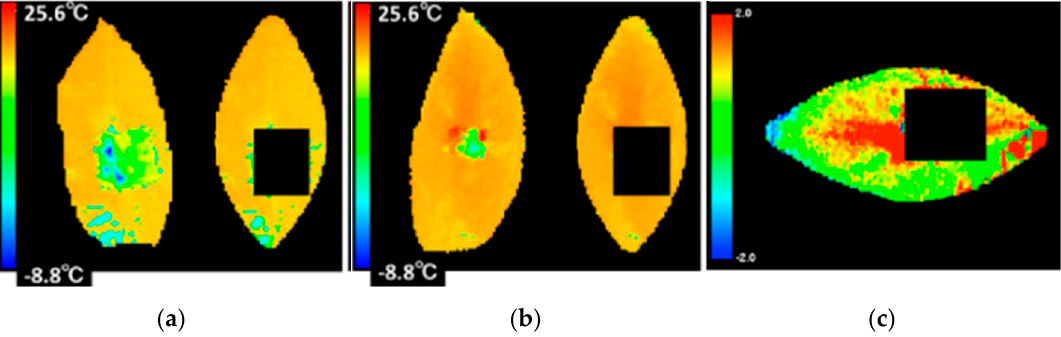
Figure 18. Thermal images of the leaves: ( a ) Strong leaf; ( b ) Weak leaf; ( c ) Temperature difference between strong leaf and weak one.